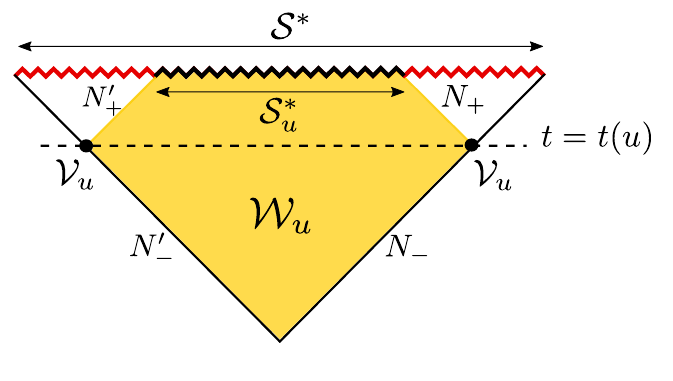
Figure 5 . WdW patch for a Kasner slab S (cid:3)